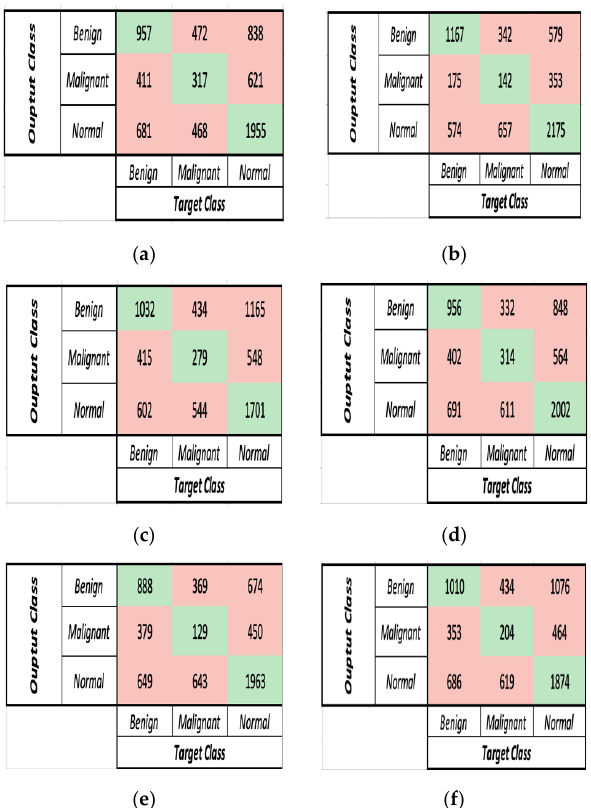
Figure 5. Confusion matrices on Dataset 1 before pre-processing for the DL models ( a ) ResNet-18, ( b ) AlexNet, ( c ) GoogleNet, ( d ) VGG-16, ( e ) MobileNetV2, ( f ) DenseNet-201. ( b ) AlexNet, ( c ) GoogleNet, ( d ) VGG-16, ( e ) MobileNetV2, ( f ) Figure 6 features the confusion matrices of the six deep learning models after imple- menting the pre-processing phase before the feature extraction phase. The comparison between the DL models in terms of accuracy and run-time after pre-processing is pre- sented in Table S5.